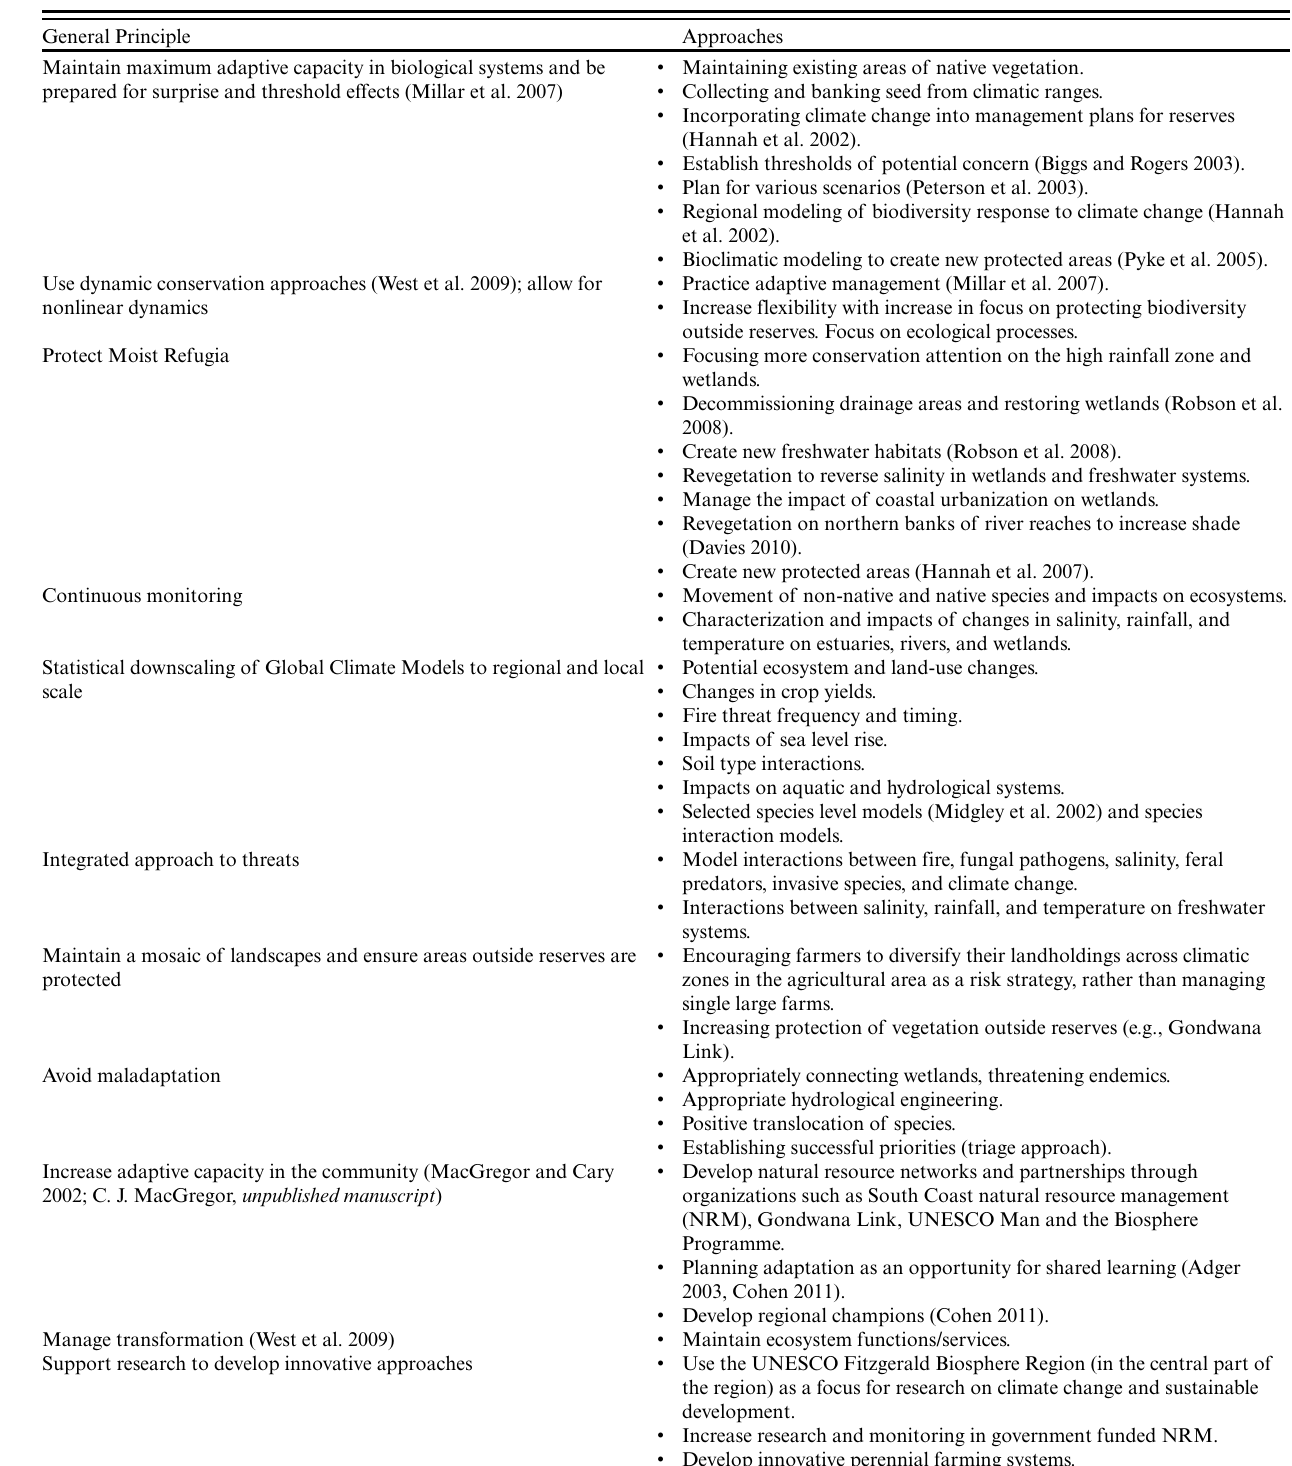
Table 3 . Ideas for maintaining and improving natural resources in the South Coast Region under projected climate and land-use